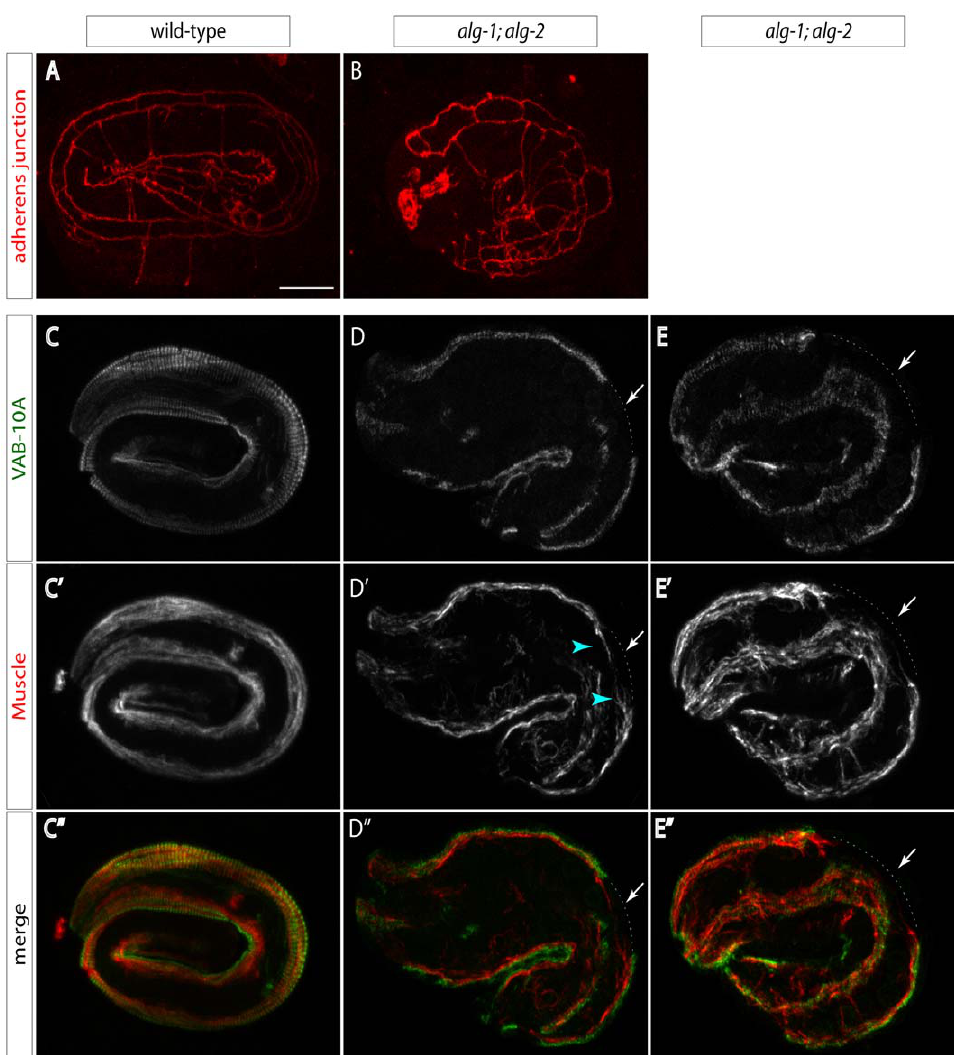
Figure 8. ALG-1/2 function is required to maintain muscles and the epidermis. ( A–B ) Embryos collected between 6–8 hours post egg- laying at 25 u C and stained with the antibodies MH27 (adherens junction). The alg-1; alg-2 mutant embryo did not progress beyond the two-fold stage, yet has grossly normal junctions. ( C–E ) Embryos collected between 6–8 hours post egg-laying at 25 u C and stained with the antibodies 4F2 (VAB-10A; C–E) and NE8/4C6 (muscle; C 9 –E 9 ); merge picture (C 0 –E 0 ). Arrow, are where the fibrous organelle (D–E) and muscle (D 9 –E 9 ) pattern is partially interrupted; in addition, muscles do not closely follow the body wall in this area (they should be closer to the blue dotted line; see blue arrowheads). Embryos did not elongate beyond the two-fold